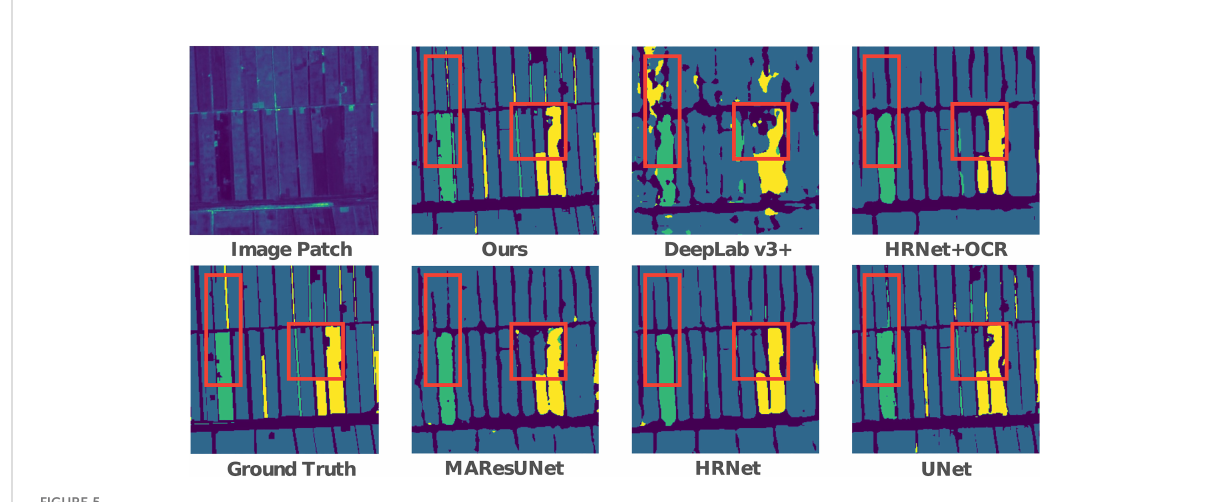
FIGURE 5 Visual prediction comparison of different